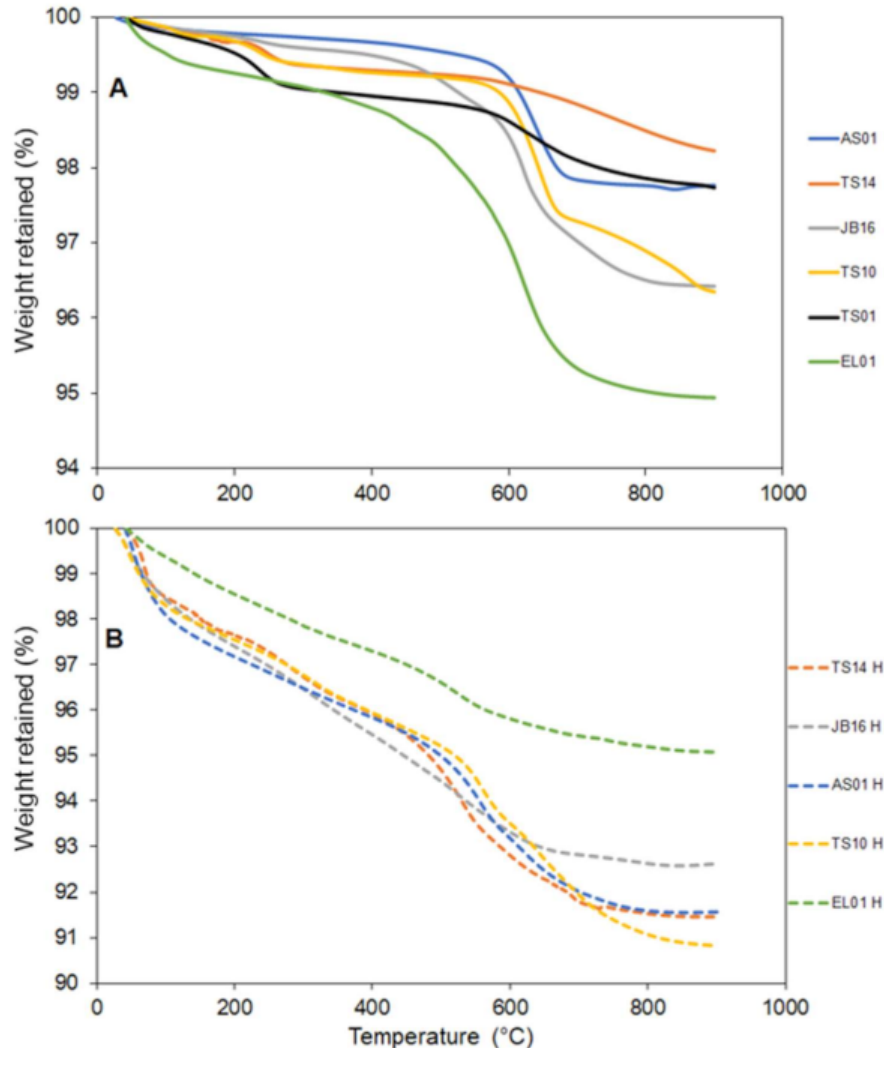
Figure 9. Thermal gravimetric analyses (TGA) of TS01, TS10, TS14, JB06, AS01, and EL01 samples ( A ) and their hydrothermal equivalent ( B ) from room temperature to 900 ◦